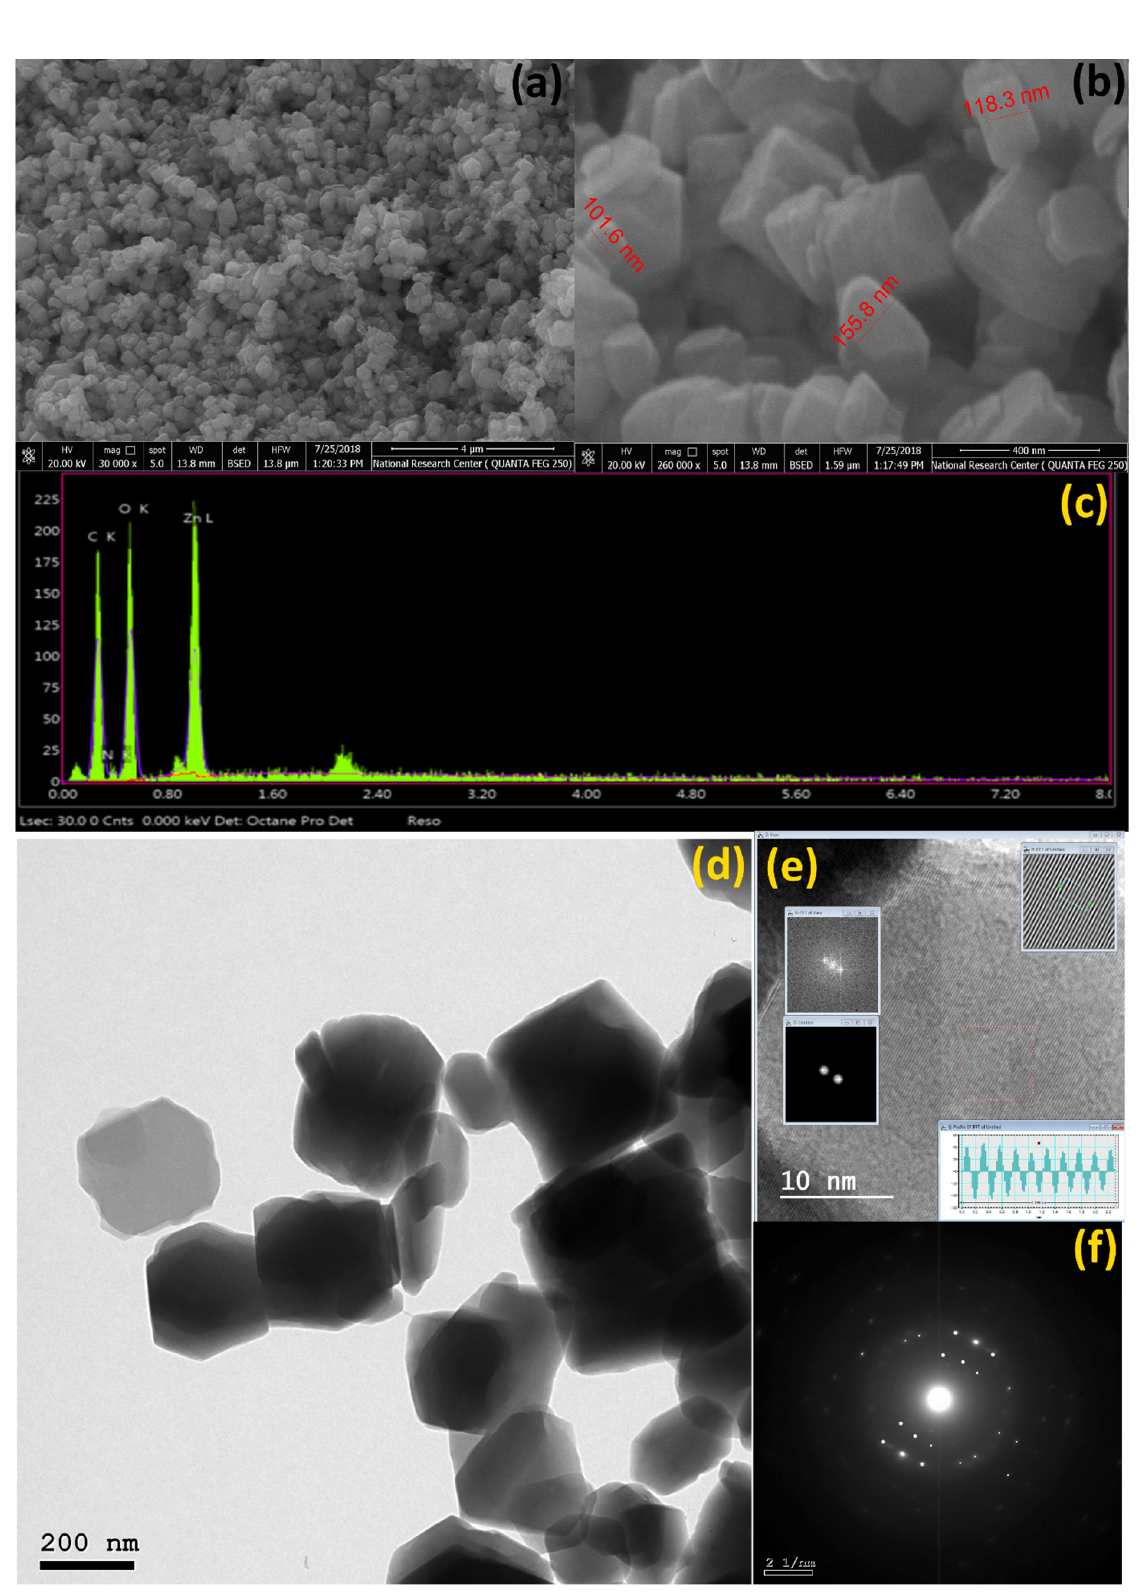
Figure 1. ( a , b ) FE-SEM images of the Zn-M Ο Fs-NP at distinct magnifications, ( c ) mapping analysis (EDX) of the Zn-M Ο Fs-NP, and ( d – f ) HR-TEM) and SAED images of the Zn-M Ο Fs-NP.